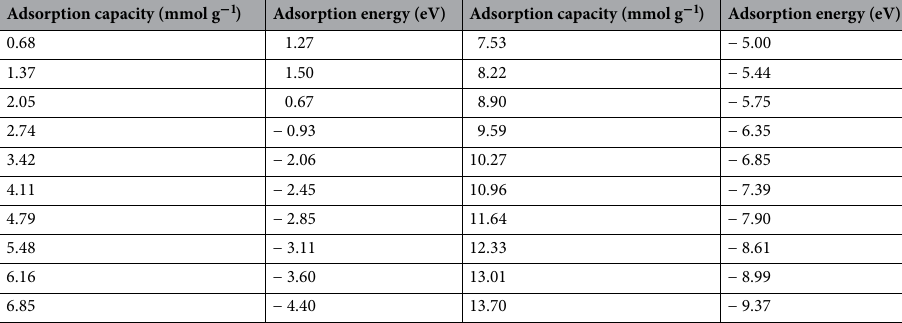
Table 1. The adsorption energies of different adsorption capacity within montmorillonite layer.